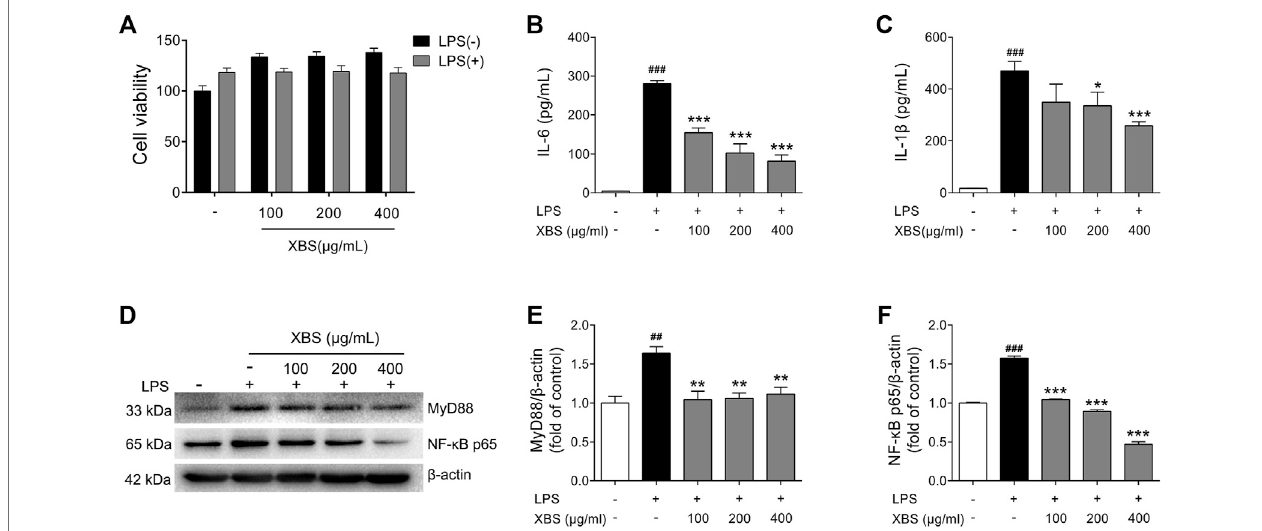
FIGURE 7 | Effects of XBS on in fl ammatory responses induced by LPS in RAW 264.7 cells. (A) Cell viability measured after treatment with XBS alone or XBS in combinationwithLPSfor24 h.LevelsofIL-6 (B) andIL-1 β (C) inculturesupernatantsweremeasuredusingELISAkits. (D-F) Representativewesternblotsshowingthe protein of MyD88 and NF- κ B p65 changes and normalized to β -actin. Similar results were obtained from three independent experiments. The values are presented as means ± SD. ## p < 0.01 and ### p < 0.001 vs. the control group. * p < 0.05, ** p < 0.01 and *** p < 0.001 vs. the LPS group.